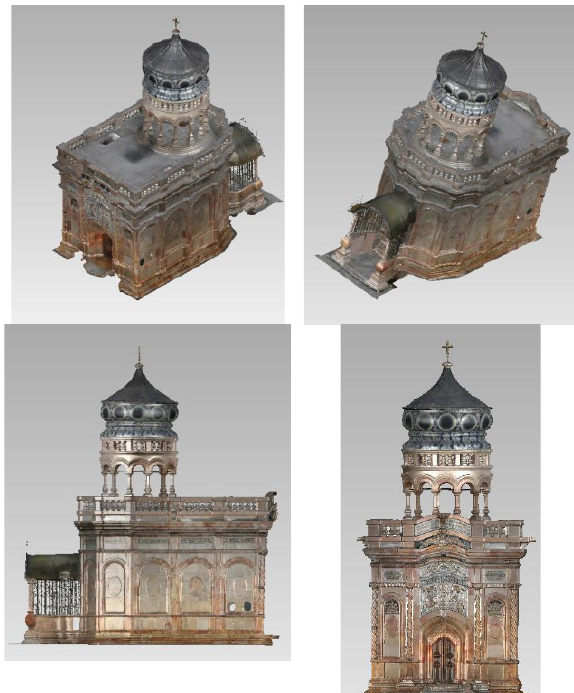
Figure 4. The exterior of the 3D model from various